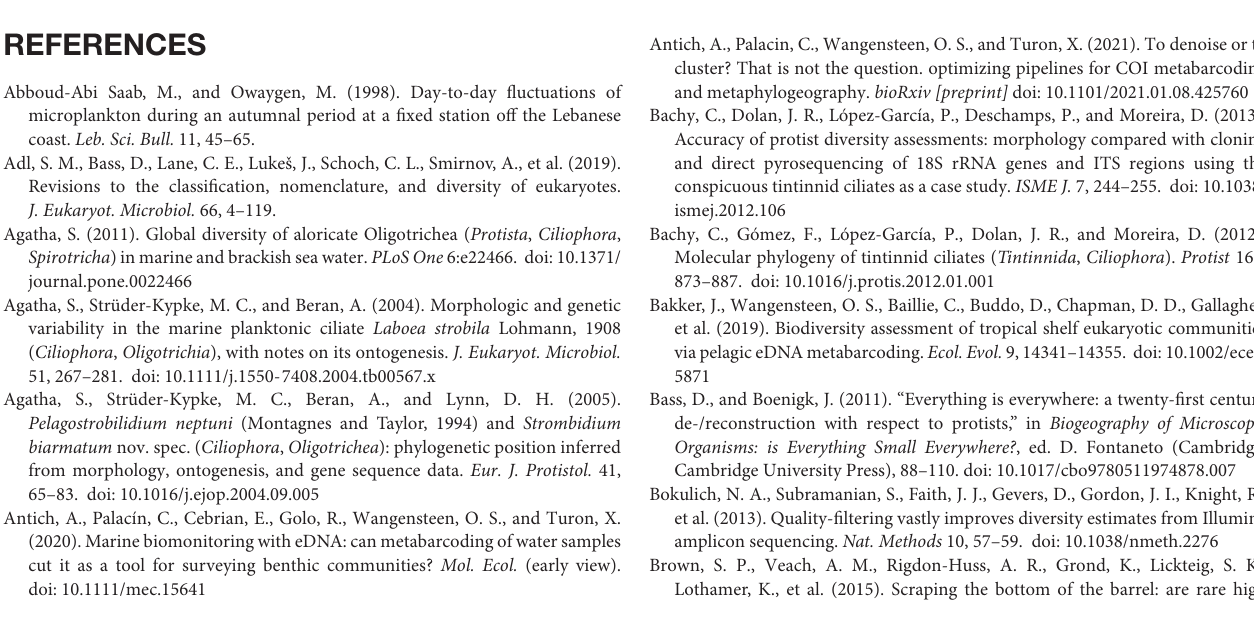
Supplementary Figure 1 | Phylogenetic analyses of the oligotrichids Spirotontonia sp. (A,B) , Strombidium K sp. (C,D) , Strombidiidae K X sp. (E,F) , and the tintinnid Tintinnidium sp. (G,H) . (A,C,E,G) Phylogenetic trees based on the representative Swarm OTU amplicons obtained in the present study. The green dots mark the branches selected as query (Q) and reference groups (R) in the DeSignate analyses for identifying signature nucleotides. (B,D,F,H) Phylogenetic trees based on the representative Swarm OTU amplicons obtained by the present study and reference sequences from GenBank and the PR 2 database. Supplementary Figure 2 | Distribution of signature nucleotides detected by DeSignate (Hütter et al., 2020) in the Swarm OTU sequence alignments of the four taxa displaying distinct geographic patterns. Supplementary Figure 3 | Signature nucleotides identified by DeSignate (Hütter et al., 2020). The upper line displays the V4 sequence with the position of the signature nucleotides. The middle and lower left portions demonstrate the entropy plot (blue line) of the alignment shown below. The upper portion of the alignment comprises the query group sequences, the lower portion the reference group sequences. In the lower right portion, the alignment positions are ranked according to their relevance. Green, binary signatures; orange, asymmetric signatures; gray, noisy characters. Supplementary Figure 4 | Examples of Swarm OTU networks. The networks display the internal structure of Swarm OTUs, in which nodes represent amplicons and edges represent one nucleotide differences between the amplicons. The node size was scaled to the read abundance comprised within an amplicon. (A) Swarm OTU with main area of distribution in Chinese coastal waters. (B) Swarm OTU with main area of distribution in European coastal waters. Supplementary Table 1 | Sampling data. Supplementary Table 2 | List of the 21 oligotrichean taxa included in the phylogenetic analyses (1); signature nucleotides detected in the four taxa with distinct geographic patterns (2); list of reference sequences obtained from GenBank and the PR 2 database (3). Supplementary Data 1 | Modifications to the DNA extraction protocol and details on the nested-PCR. Supplementary Data 2 | Alignments and tree files of the 21 oligotrichean taxa included in the phylogenetic